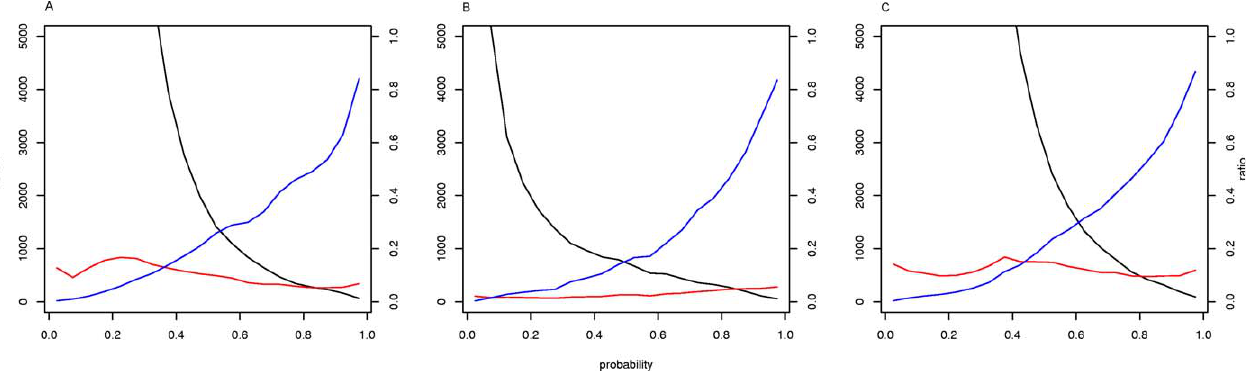
Figure 1. Performance of MAMMOTH Confidence Metric on Benchmark Set (A) Alpha-helical protein model, (B) beta-sheet protein model, and (C) alpha-helical/beta-sheet protein model. The x -axis is the P MCM ; the y -axis the number of matches that are incorrect (black) and correct (red). The blue line is the ratio (correct/incorrect).